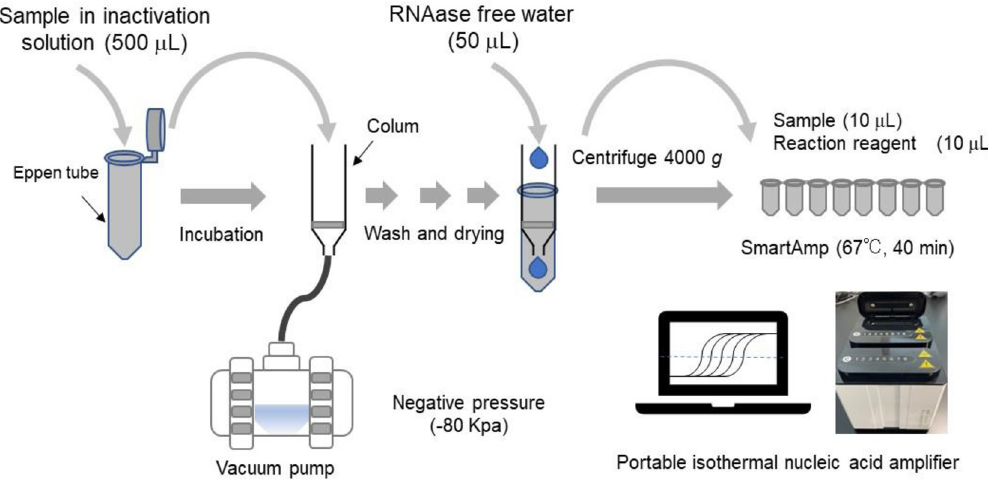
Fig 1. Schematic diagram of the RNA quantification